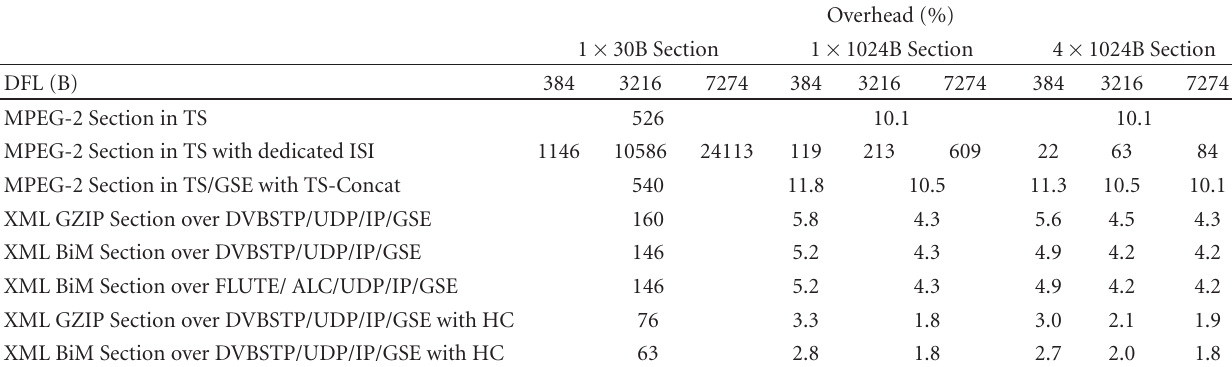
Table 5: Overhead for di ff erent combinations of syntax and encapsulation